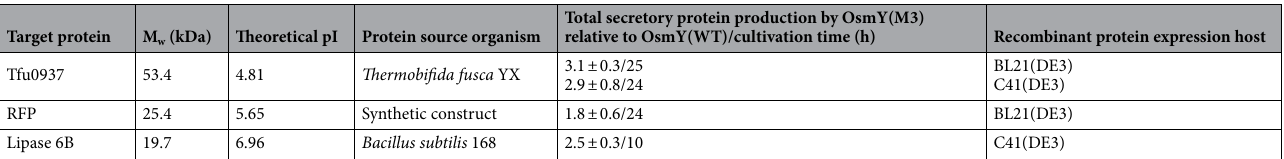
Table 2. Production of secretory protein using OsmY(WT) and OsmY(M3) for three different target